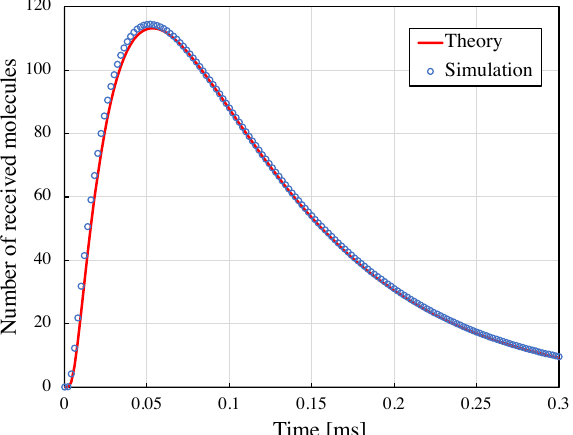
Figure 6. Calculation examples of number of molecules received in diffusive molecule communication.